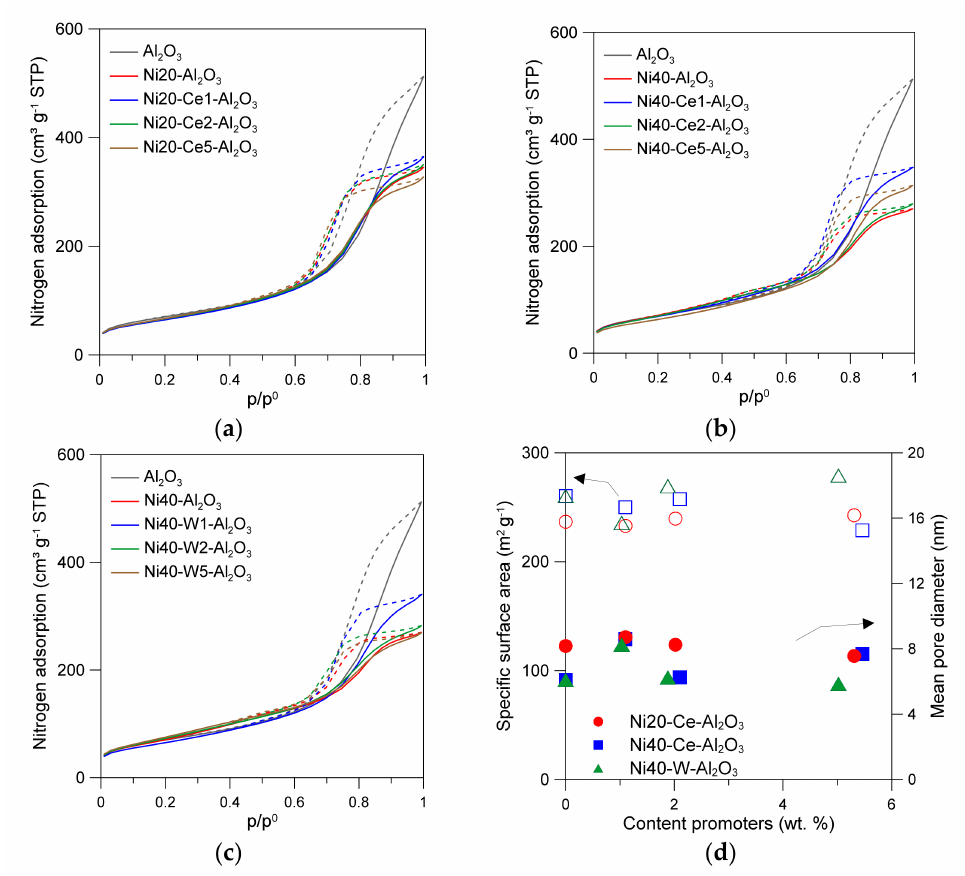
Figure 1. Low-temperature nitrogen adsorption/desorption isotherms of catalysts ( a – c ); relations between content of promoters and the specific surface area, as well as and mean pore volume of catalysts ( d